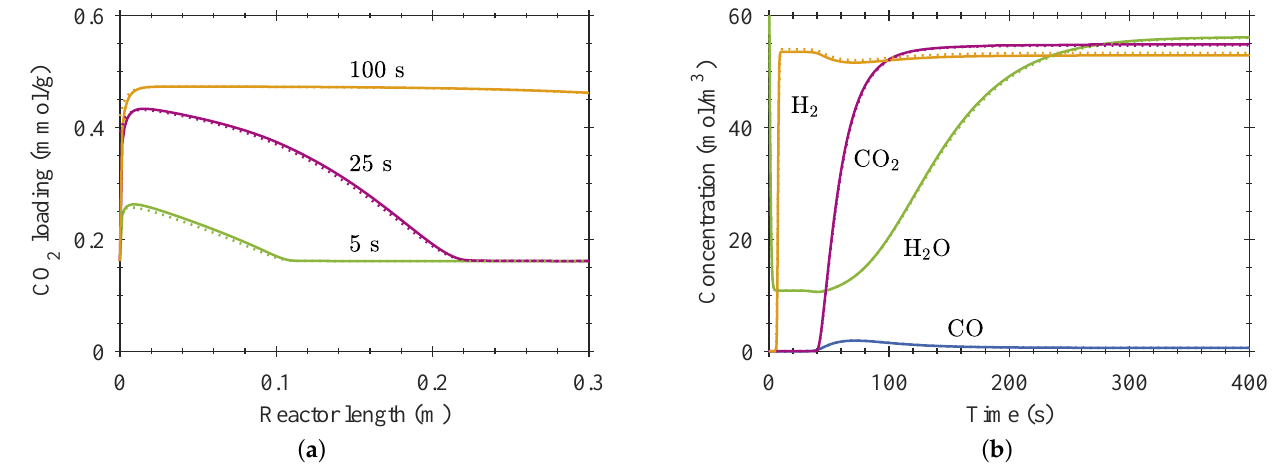
Figure 7. Comparison of MoL and Simulink ( N = 100) simulation results for reactive adsorption in one reaction chamber. ( a ) CO 2 loading at various adsorption times as a function of the reactor length, and ( b ) bulk phase concentrations at reactor outlet as a function of time. Solid lines: MoL; dotted lines: Simulink ( N =